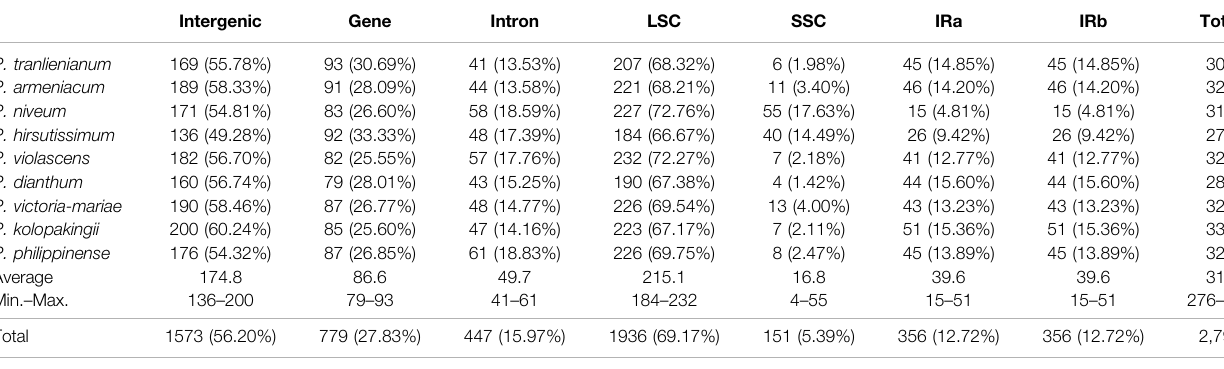
TABLE 2 | Number of SSRs (percentage in the total) in different regions of the cp genomes